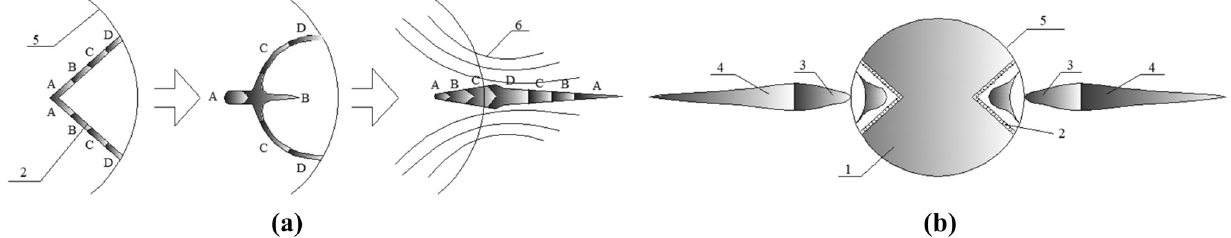
Fig. 1 Detonation process of cumulative charge (Guo et al. 2008) 1—cumulative charge; 2—liner; 3—pestle; 4—jet flow; 5—PVC tube; 6— detonation